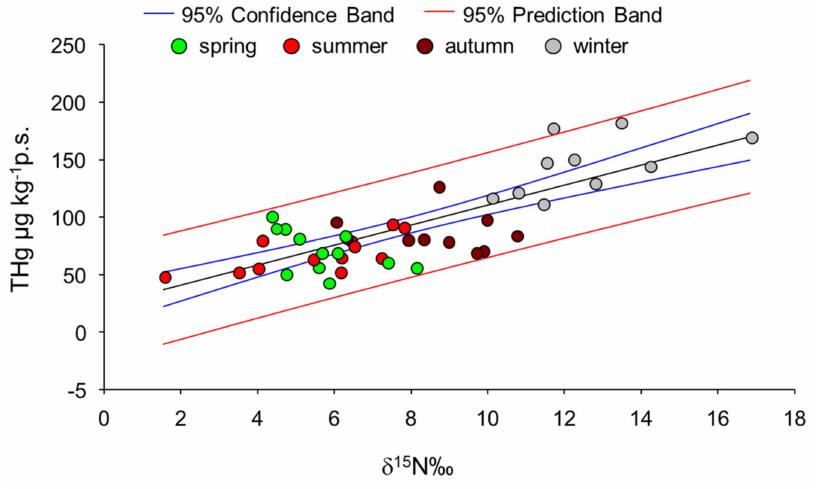
Figure 3. Relationship between total mercury concentrations and δ 15 N isotopic signature for zoo- plankton ( ≥ 450 µ m and ≥ 850 µ m size fractions) in Lake Maggiore during the four seasons of the investigated years (2014 and